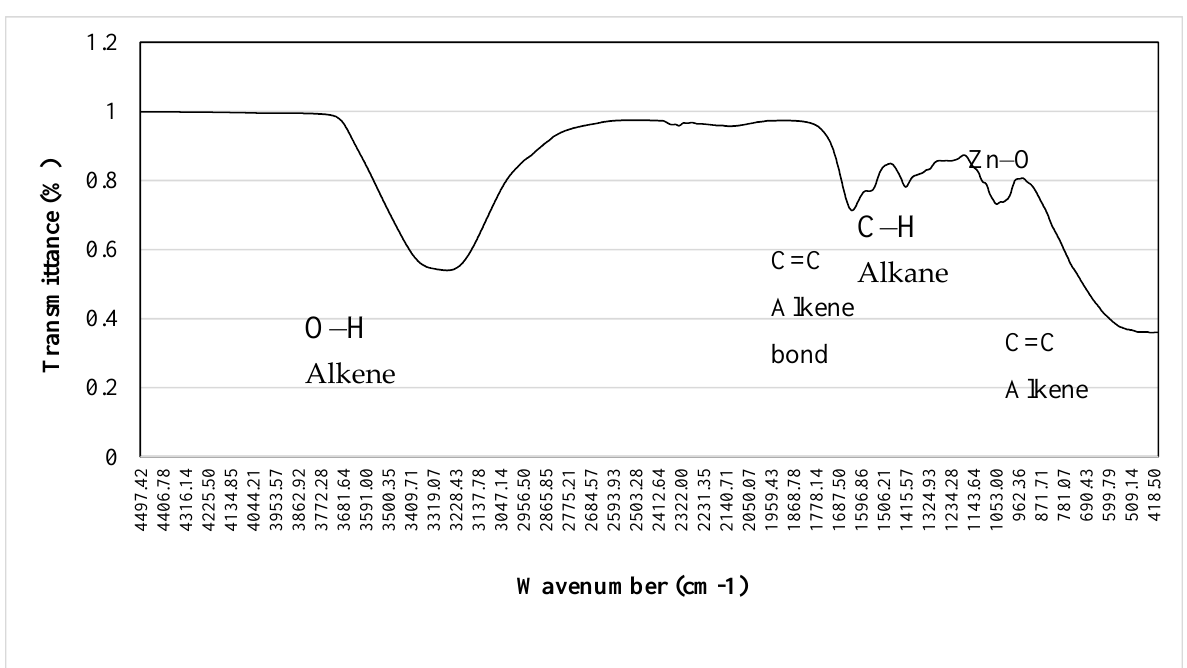
Figure 2. Fourier-transform infrared spectroscopy analysis (FTIR) of C. siliqua bio-ZnONPs.